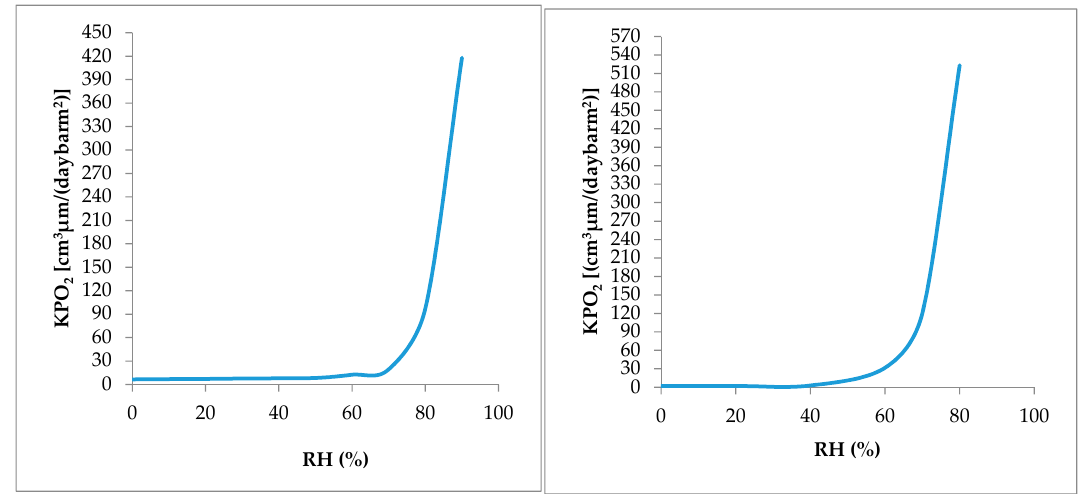
Figure 4. Effect of relative humidity on oxygen permeability coefficients of ethyl vinyl alcohol (EVOH) films ( left ) and cellulose nanocrystals (CNCs) films ( right ), (modified) [73,74]. EVOH is a thermoplastic material that can be coextruded, coated and laminated in multilayered structures while a neat NC is not a thermoplastic one; therefore, it must be used in combination with thermoplastics to make their application possible in packaging. The lamination is a technique that has allowed alleviating the water sensitivity of the EVOH and made possible their use in flexible packaging materials; hence, the same strategy can also be adopted for the NC applications. That